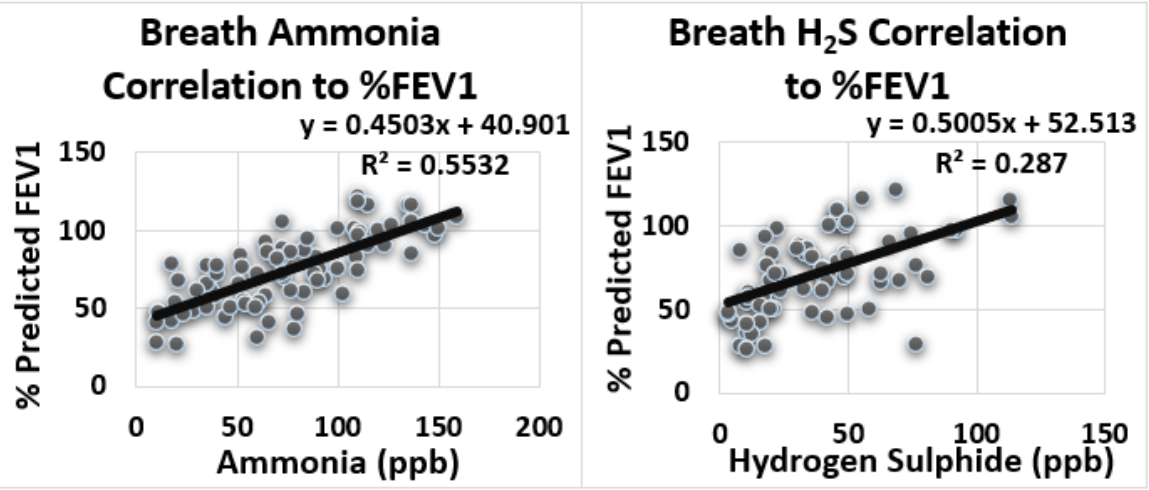
Figure 4. Correlation between exhaled breath ammonia and hydrogen sulfide to Forced Expiratory Volume in 1 s (FEV1) (% of predicted).